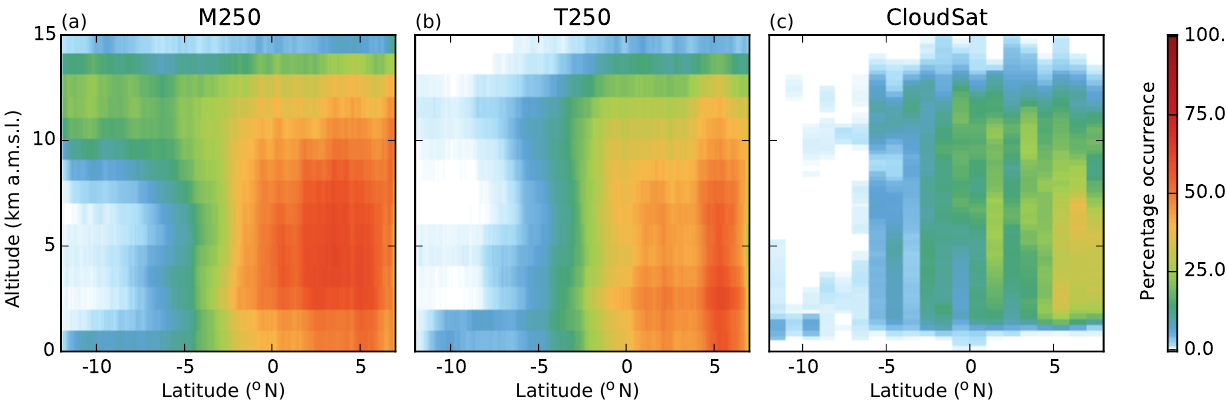
Figure 5. Congo case: 10-day histogram for the period 1–10 August 2007 of model reflectivities derived from hydrometeor fields passed through the QuickBeam radar simulator (Haynes et al., 2007); thresholded at values greater than − 20dBZ for (a) CONGO-M250, (b) CONGO-T250 and (c) the CloudSat 2B-GEOPROF product. In panels (a) and (b) the models have been sampled at the times of the nearest CloudSat